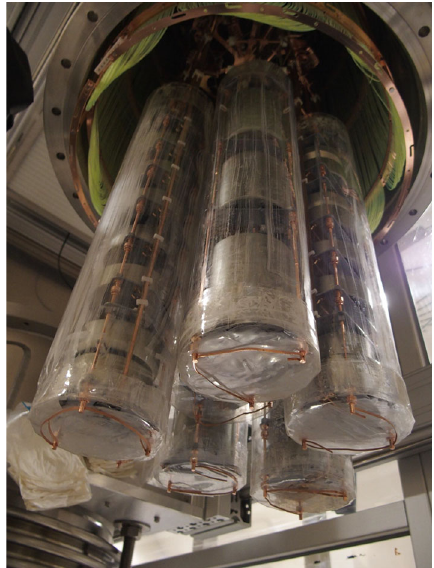
Fig. 15 Seven Gerda detectorstringswiththeNMSspriortoinsertion into the